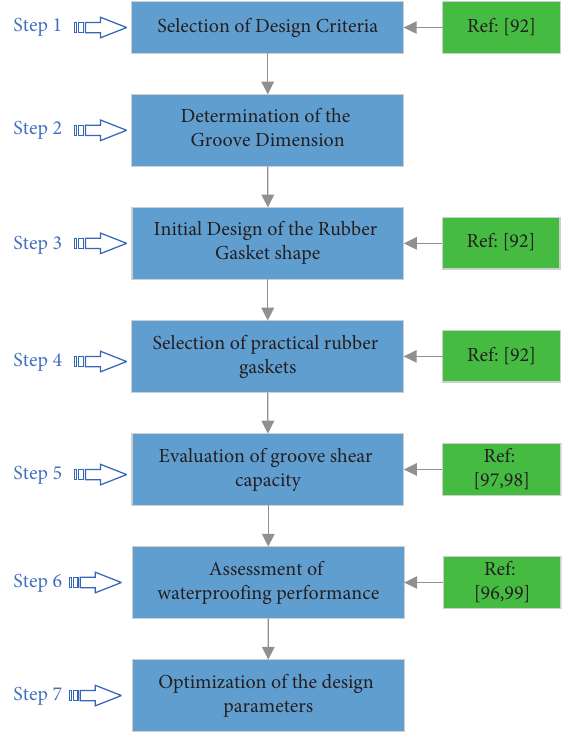
Figure 8: Specific performance-based design process for joint